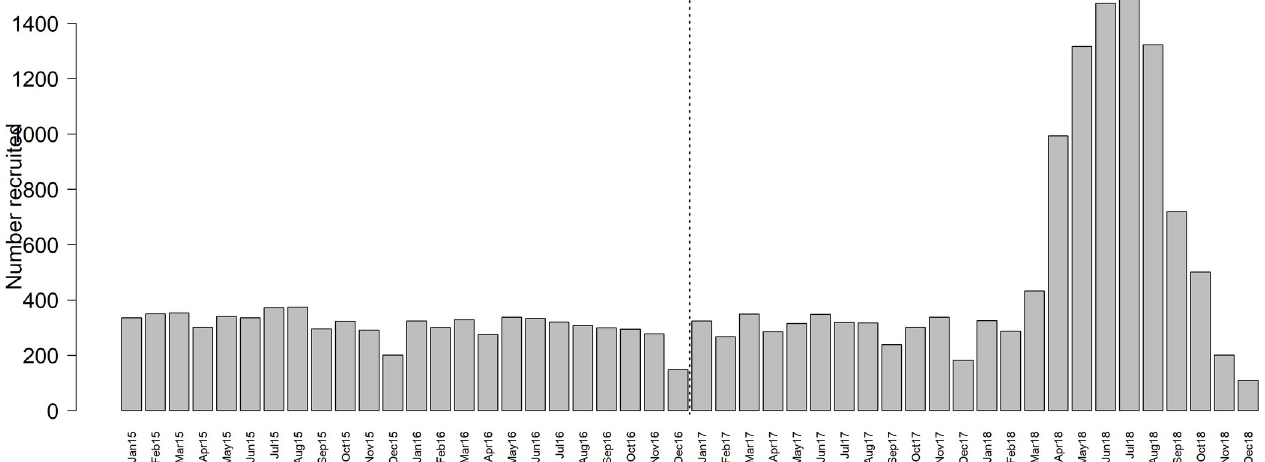
Fig 2. Bar graph showing number of HIV patients enrolled in each month from January 2015 through December 2018 comparing pre-UTT (2015–2016) and UTT (2017–2018) periods separated by a vertical dotted line.